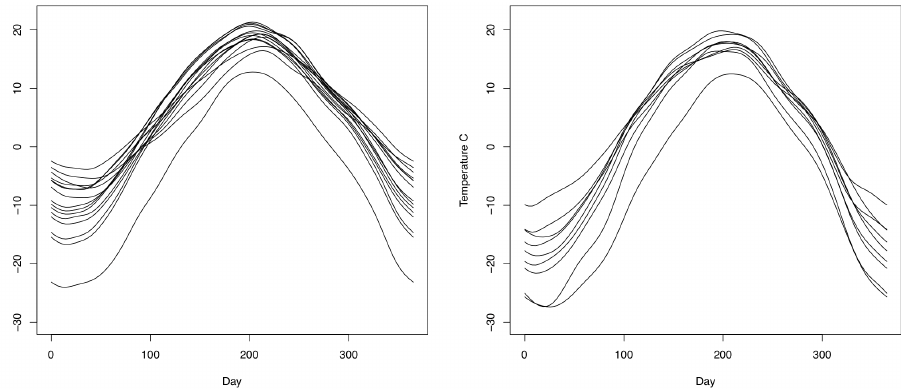
Figure 4. Temperature curves (in Celsius degrees) of the Atlantic ( left ) and Continental ( right ) climate zones obtained after daily data averages are smoothed using 65 Fourier basis